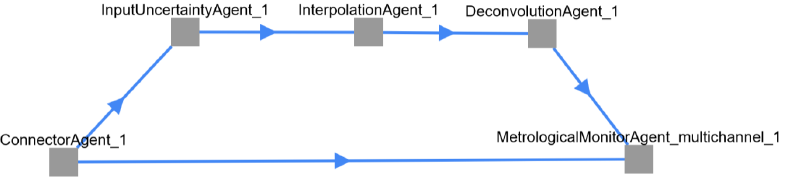
Figure 4. Implemented example: Screenshot of the network topology as shown on the dashboard.